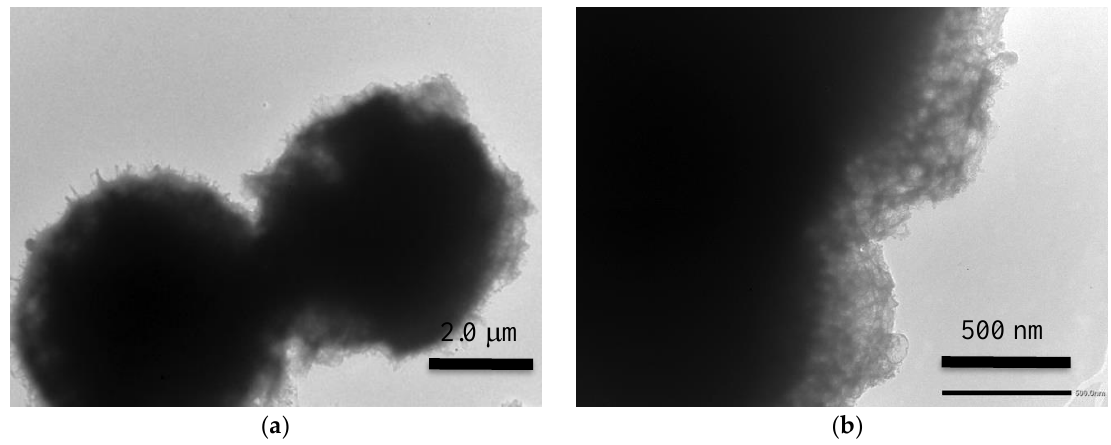
Figure 6. TEM images of activated microspheres, taken at different magnifications. In ( b ), 168 the induced porosity is evident in the peripheral area. 169 Table 1. Results of the CHNS elemental analysis of the hydrochar and of the final activated sample. 170 Sample C 1 H N Hydrochar 76.21 Activated sample